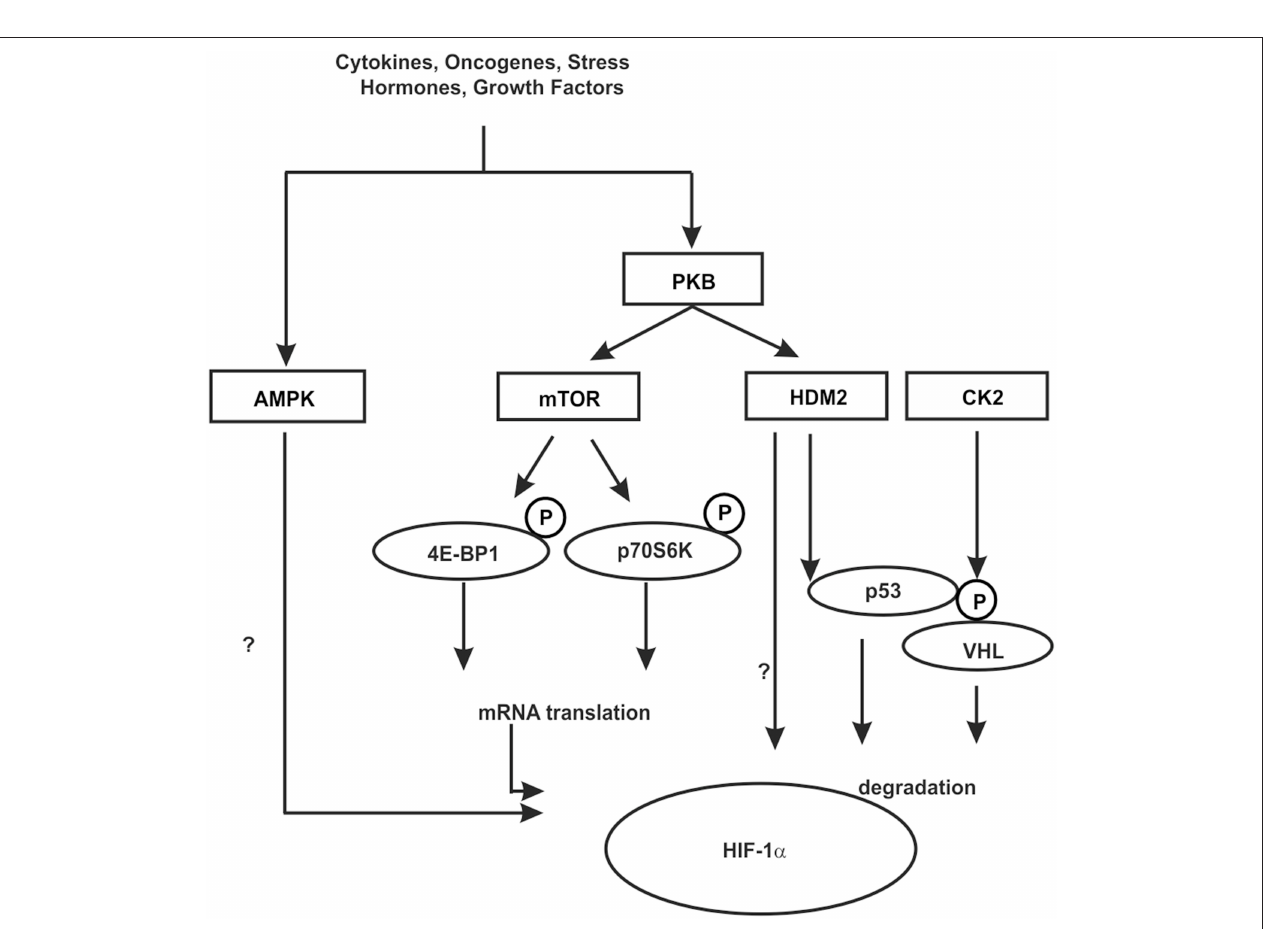
FIGURE 5 | Kinases contributing to HIF-1 α regulation in an indirect manner. In response to various hormones, growth factors, cytokines, oncogenes, and stress phosphorylation events can be initiated which contribute to the regulation of HIF-1 α in an indirect manner. These can influence HIF-1 α mRNA translation, the interaction with cofactors or components of the protein degradation machinery like HDM2 and VHL. Some kinases may act in both ways, however, the knowledge about the exact mechanisms is limited. See text for more details.